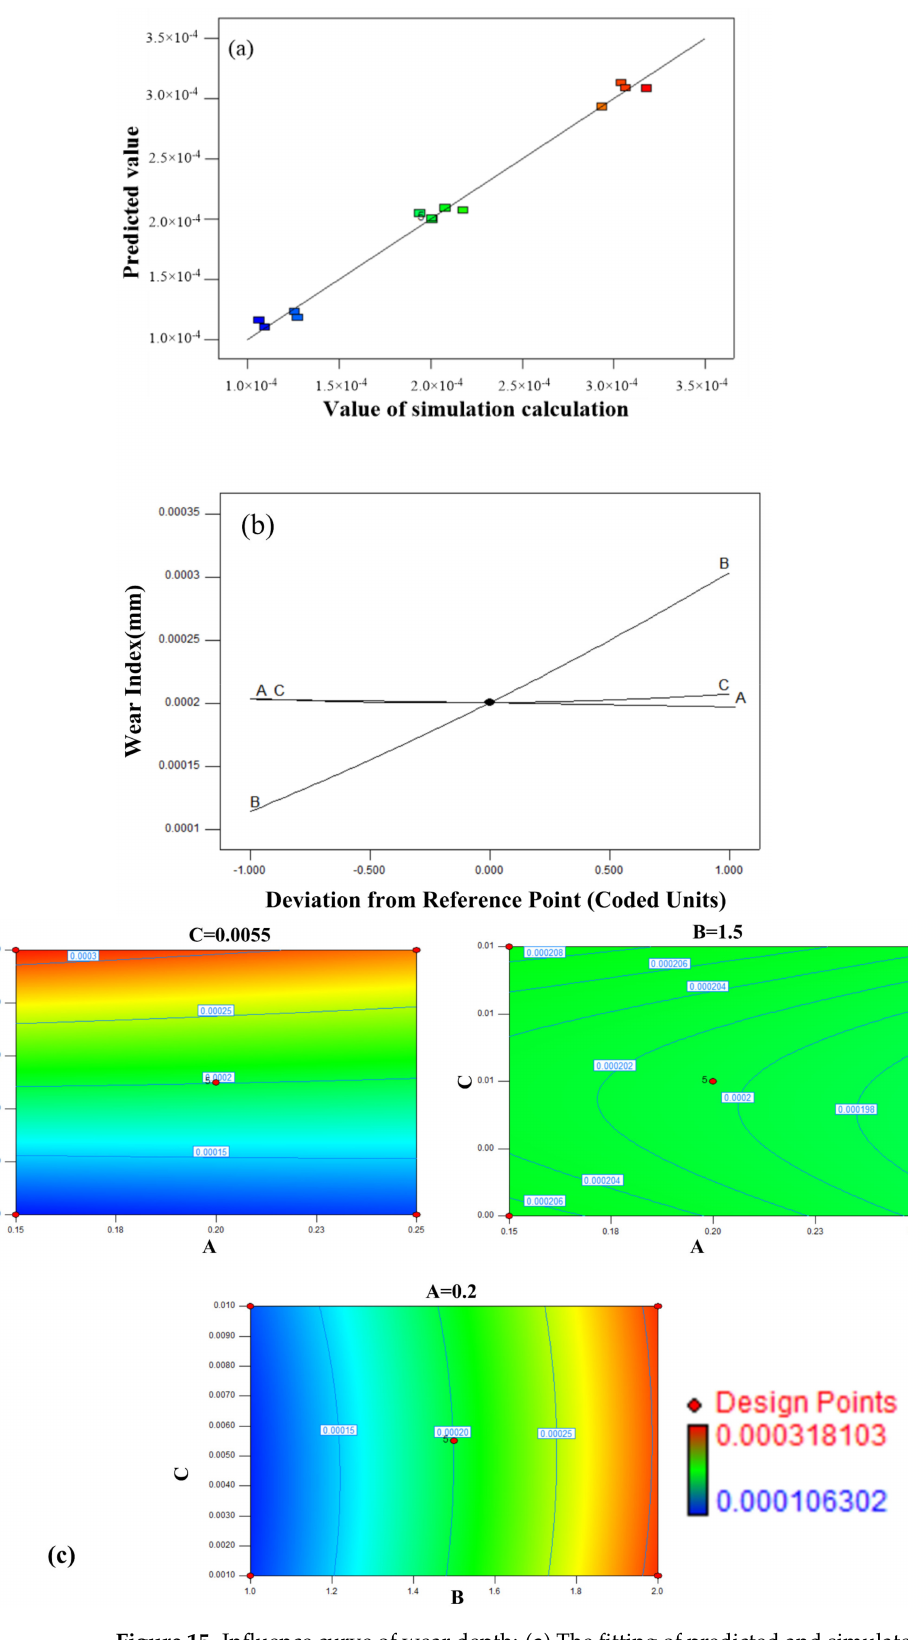
Figure 15. Influence curve of wear depth: ( a ) The fitting of predicted and simulated values. ( b ) Single factor perturbation curve. ( c ) Contour of the interaction on influence